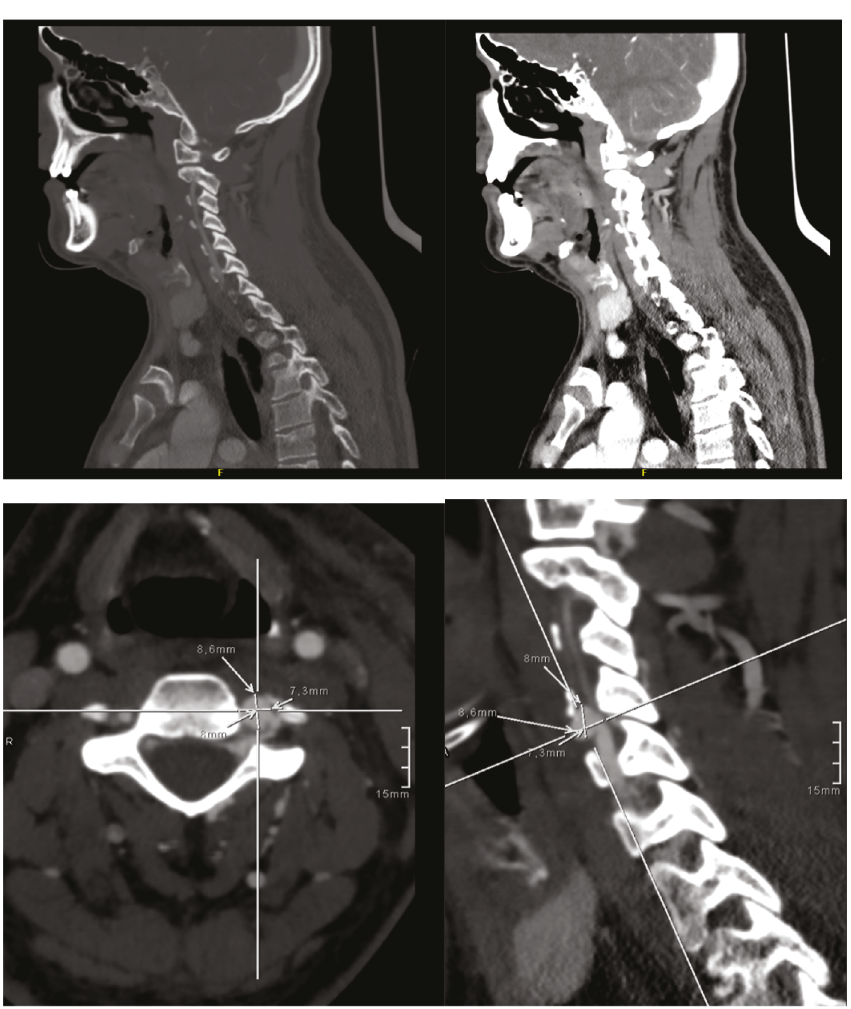
Figure 2: Angiography of the head and neck vessels. A pseudoaneurysm of the left vertebral artery is observed at the level of C4 with an associated arteriovenous fistula and without signs of active bleeding. The pseudoaneurysm measures 8.5mm anteroposterior diameter, 7.3mm transverse diameter, and 8 mm craniocaudal diameter. Hyperdensity of adjacent venous structures is observed, and the venous phase is better visualized after configuring an arteriovenous fistula with a filiform filling of the distal vertebral artery.